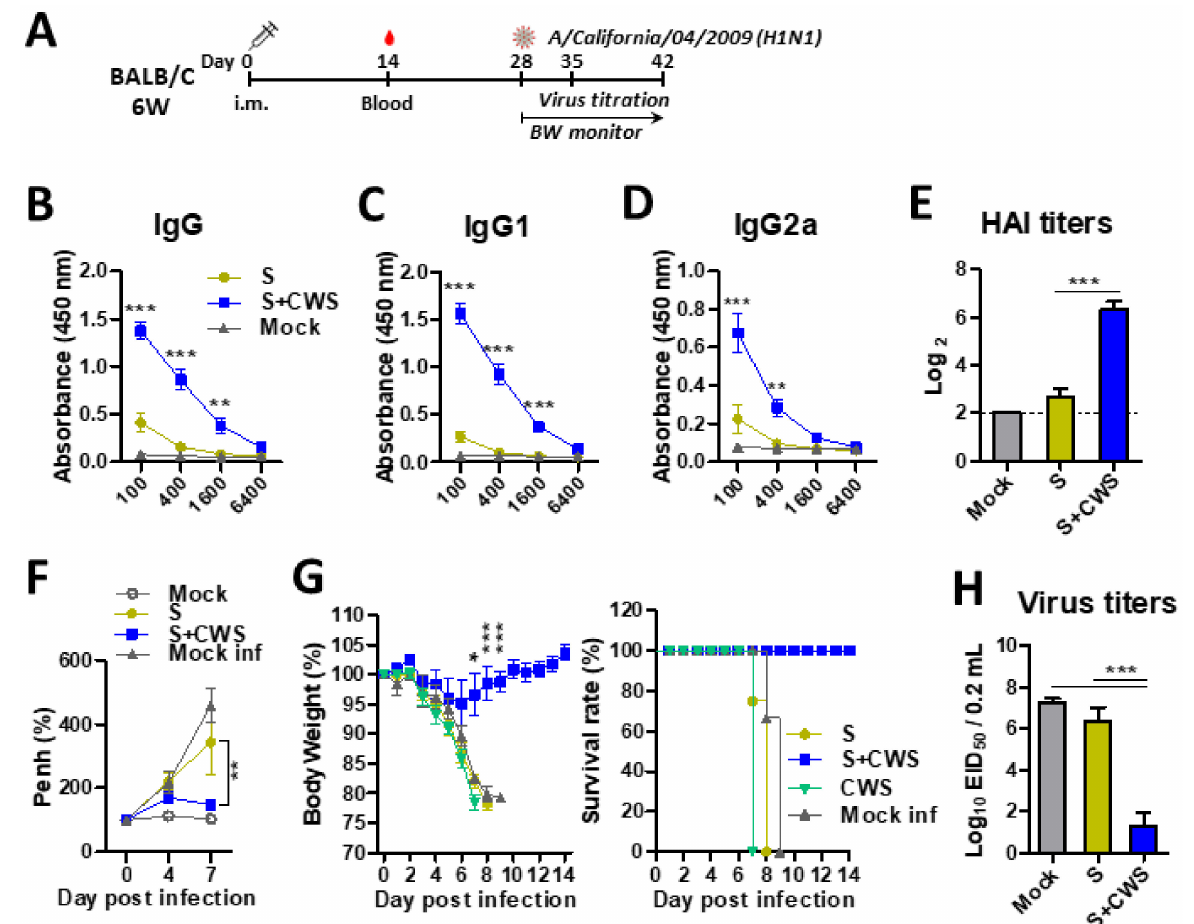
Figure 1. BCG-CWS exhibits significant adjuvant effects on enhancing IgG, HAI, and protective efficacy in adult mice after single dose influenza vaccination. ( A ) Immunization schedule ( n = 20). 6-week-old (6 W) BALB/c mice were intramuscular (i.m.) immunized either with sCal (S) or S+CWS. CWS: BCG-CWS. Blood samples were collected at 2 weeks after prime. ( B – D ) Antibody responses specific for inactivated A/Californial/04/2009 virus (iA/Cal) in prime immune sera. € Hemagglutinin inhibition titers (HAI) to A/California/04/2009 (A/Cal) were determined in prime immune sera. ( F – H ) Immunized mice were infected with A/Cal virus at a dose of 2 × LD 50 (50% mouse lethal dose) equivalent to 3 × 10 3 EID 50 (50% embryo infectious dose) at 4 weeks after prime. PenH ( F ) and body weight changes or survival rates ( G ) were monitored for 7 days and 14 days ( n = 10), respectively. ( H ) Lung viral titers were determined by an egg inoculation assay at 7 days post infection ( n = 10). Mock: PBS control and no infected, S: split sCal vaccine only, S+CWS: split plus CWS, CWS: BCG-CWS adjuvant only, Mock inf: PBS and infected with A/Cal virus. Statistical significance was calculated by using one- or two-way ANOVA and a Bonferroni’s multiple-comparison test. Error bars indicate the mean ± SEM. *; p < 0.05, **; p < 0.01, ***; p <